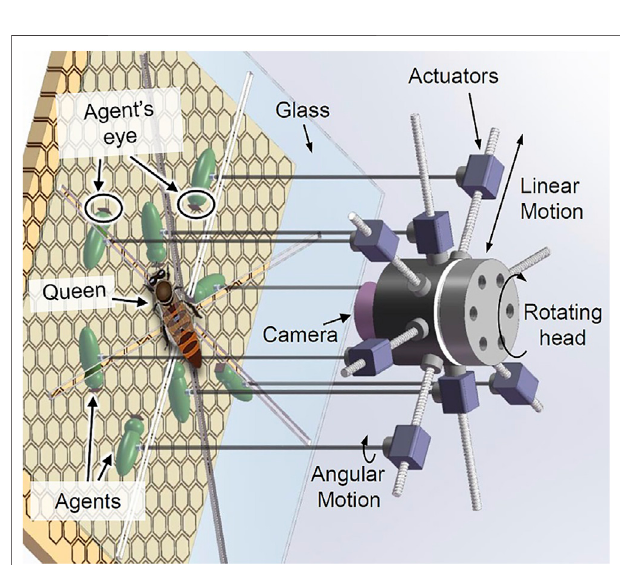
FIGURE 2 | Internal structure of the robot with eight physical agents which can rotate and move forward/backward